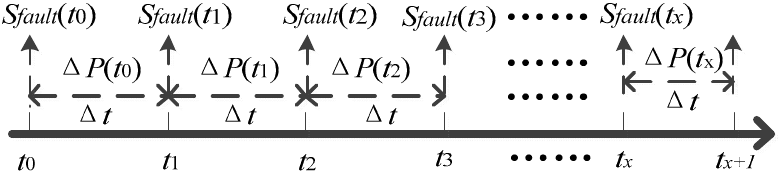
Figure 1. Diagram of the accumulation effect on operation risk costs.